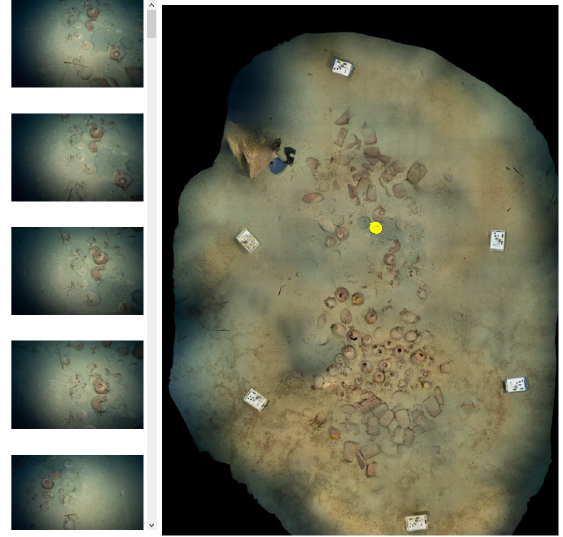
Figure 9: Xlendi orthophoto and photographs corresponding to the selected amphorae